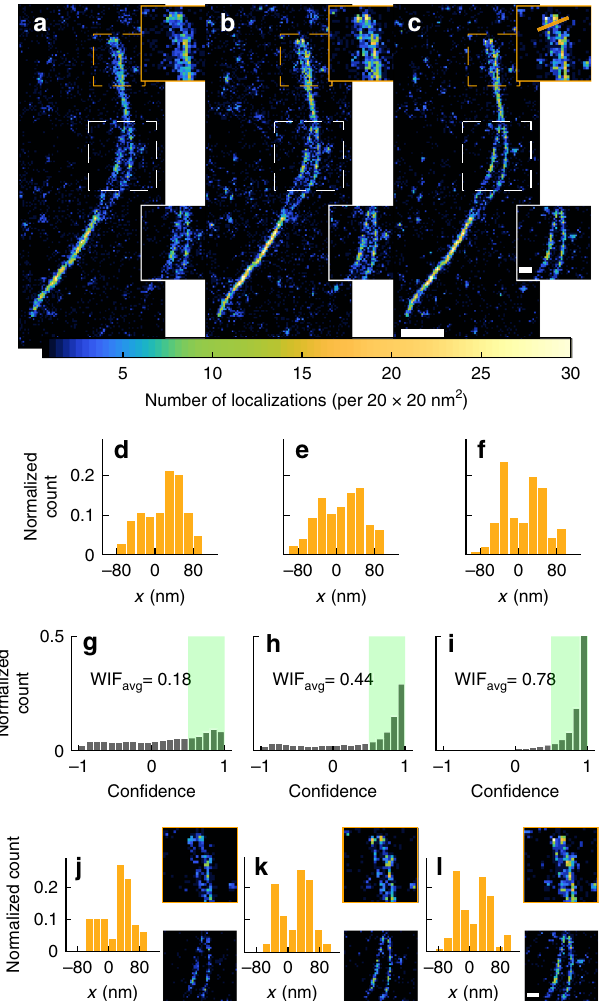
Fig. 4 Quantifying algorithmic robustness and enhancing reconstruction accuracy in SMLM of amyloid fi brils. Super-resolution image of twisted fi brils recovered by a TS-weighted least-squares (WLS), b TS maximum- liklihood estimation (MLE), and c RoSE. d – f Histograms of localizations projected onto the gold line in c (top inset) from d WLS, e MLE, and f RoSE. WIFs for g all WLS localizations in ( a ), h all MLE localizations in ( b ), and i all RoSE localizations in ( c ). Green regions denote localizations with con fi dence >0.5. j – l Histograms of localizations with con fi dence >0.5 projected onto the golden line in c (top inset) and corresponding fi ltered inset images for j WLS, k MLE, and l RoSE. Color bar: number of localizations per 20 × 20 nm 2 . Scale bars: c 500 nm, c inset 150 nm, and l inset 150 nm.